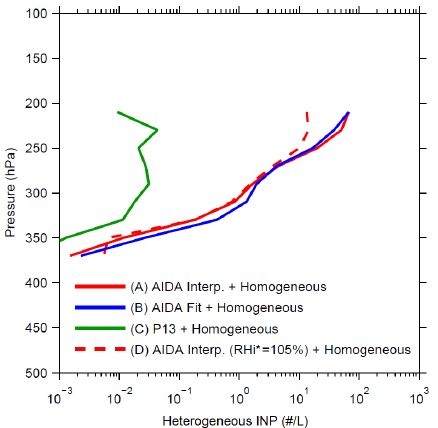
Figure 7. The mean heterogeneous INP number concentrations ( ∼ N ice ) simulated in COSMO. The red dashed line represents the simulation with 105% RH ice as the lower boundary of ice forma- tion, while the others are based on with 100% for the minimum RH ice value.